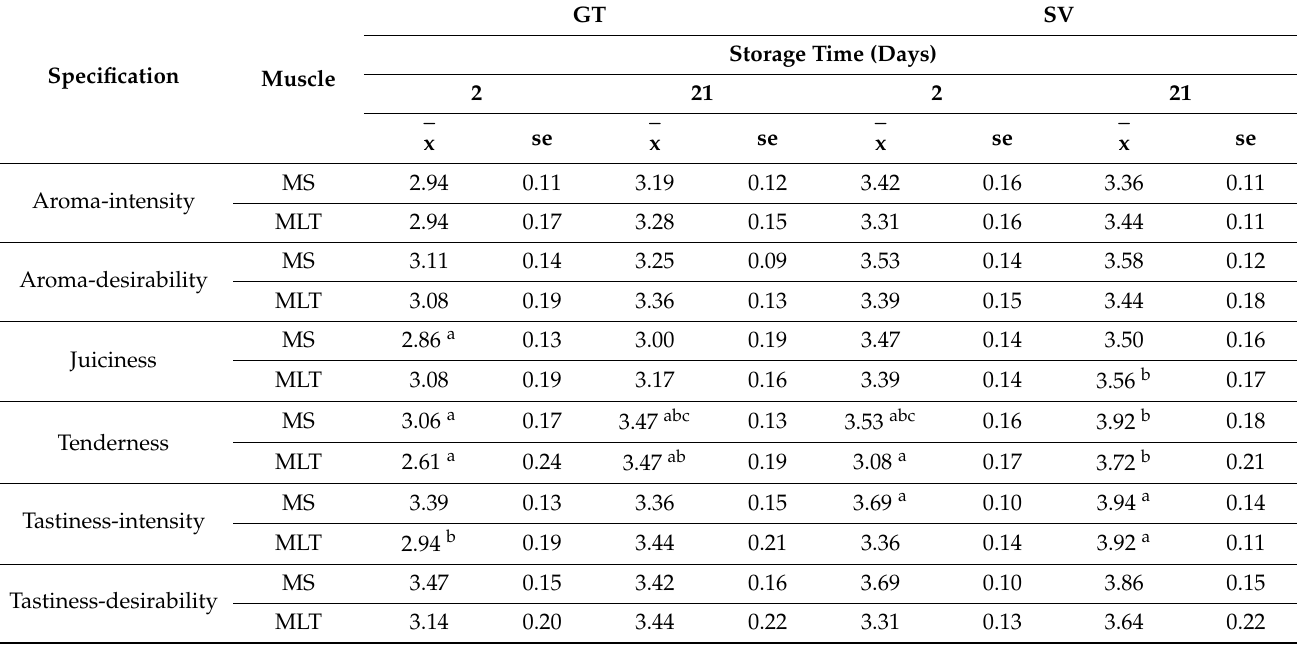
Table 5. Sensory properties of beef depending on the type of meat, cold storage time and thermal treatment used